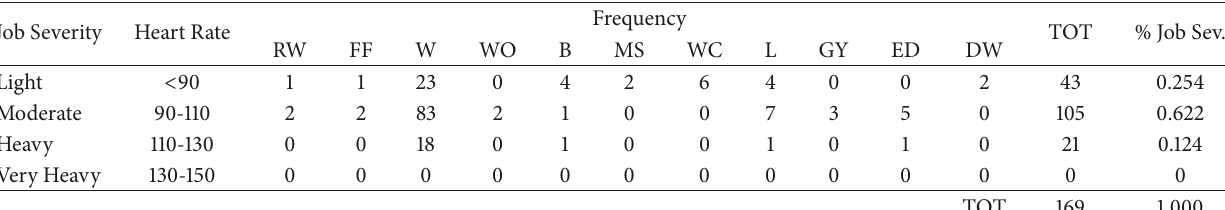
(a) Operator “A” percentage of job severity obtained from the work sampling.